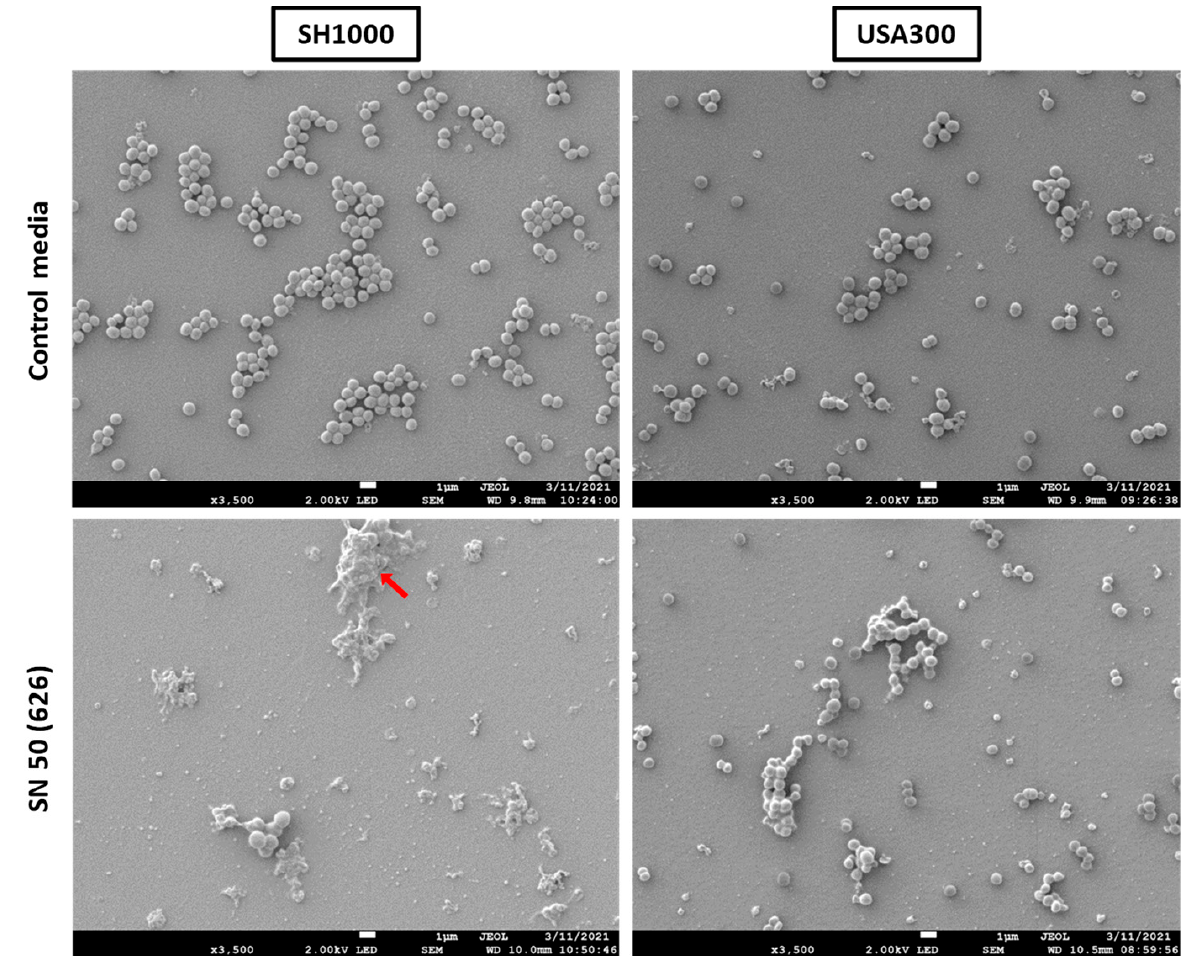
Figure 7. Impact of primary osteoblast culture supernatant on S. aureus biofilm shape and matrix. Control media (50% [DMEM + 10% FBS] and 50% MM), SN 50 (626) (50% primary human osteoblast culture supernatant and 50% MM), or All SN 50 (addition of results of SN 50 (625, 626, 634 and 636)). Red arrow indicates agglomerated dead bacteria. Two coverslips were imaged for each donor of primary osteoblast culture supernatant and the corresponding control media. The scale bars indicate 1 µm.